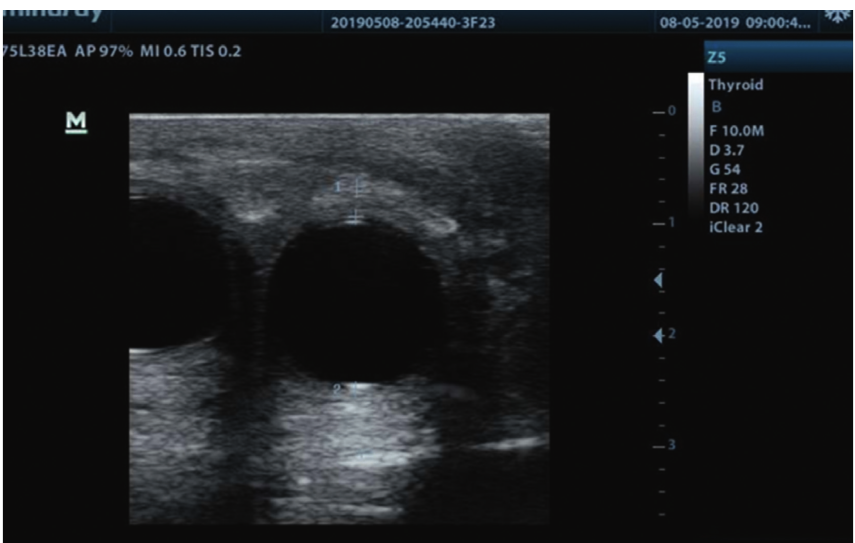
Figure 1: Inflated cylinders. 2D ultrasound image showing the inflated cylinders before penile hemodynamic measurement.